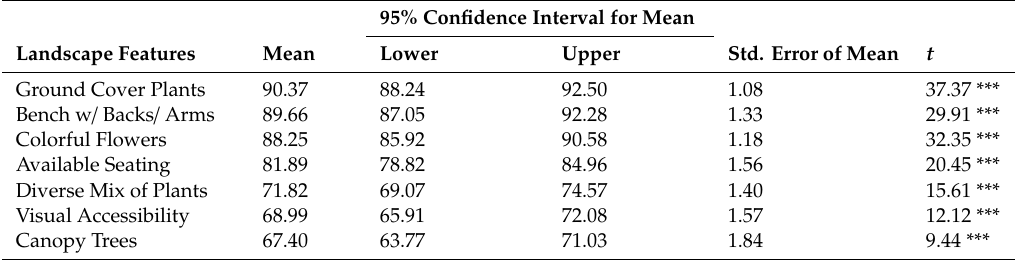
Table 2. Measure of preference for hypothesized